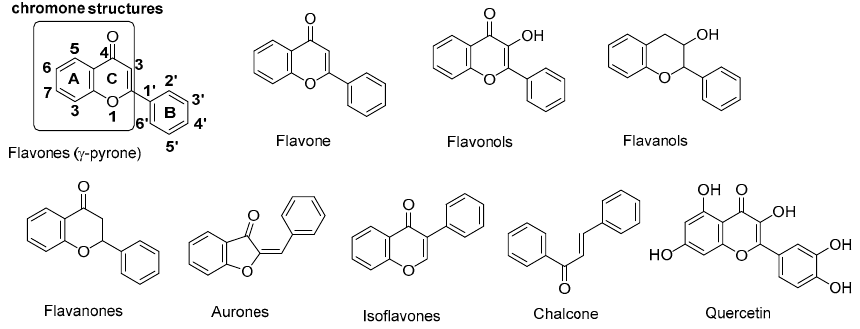
Figure 1. Structures and numbering system of fl avones and derivatives.